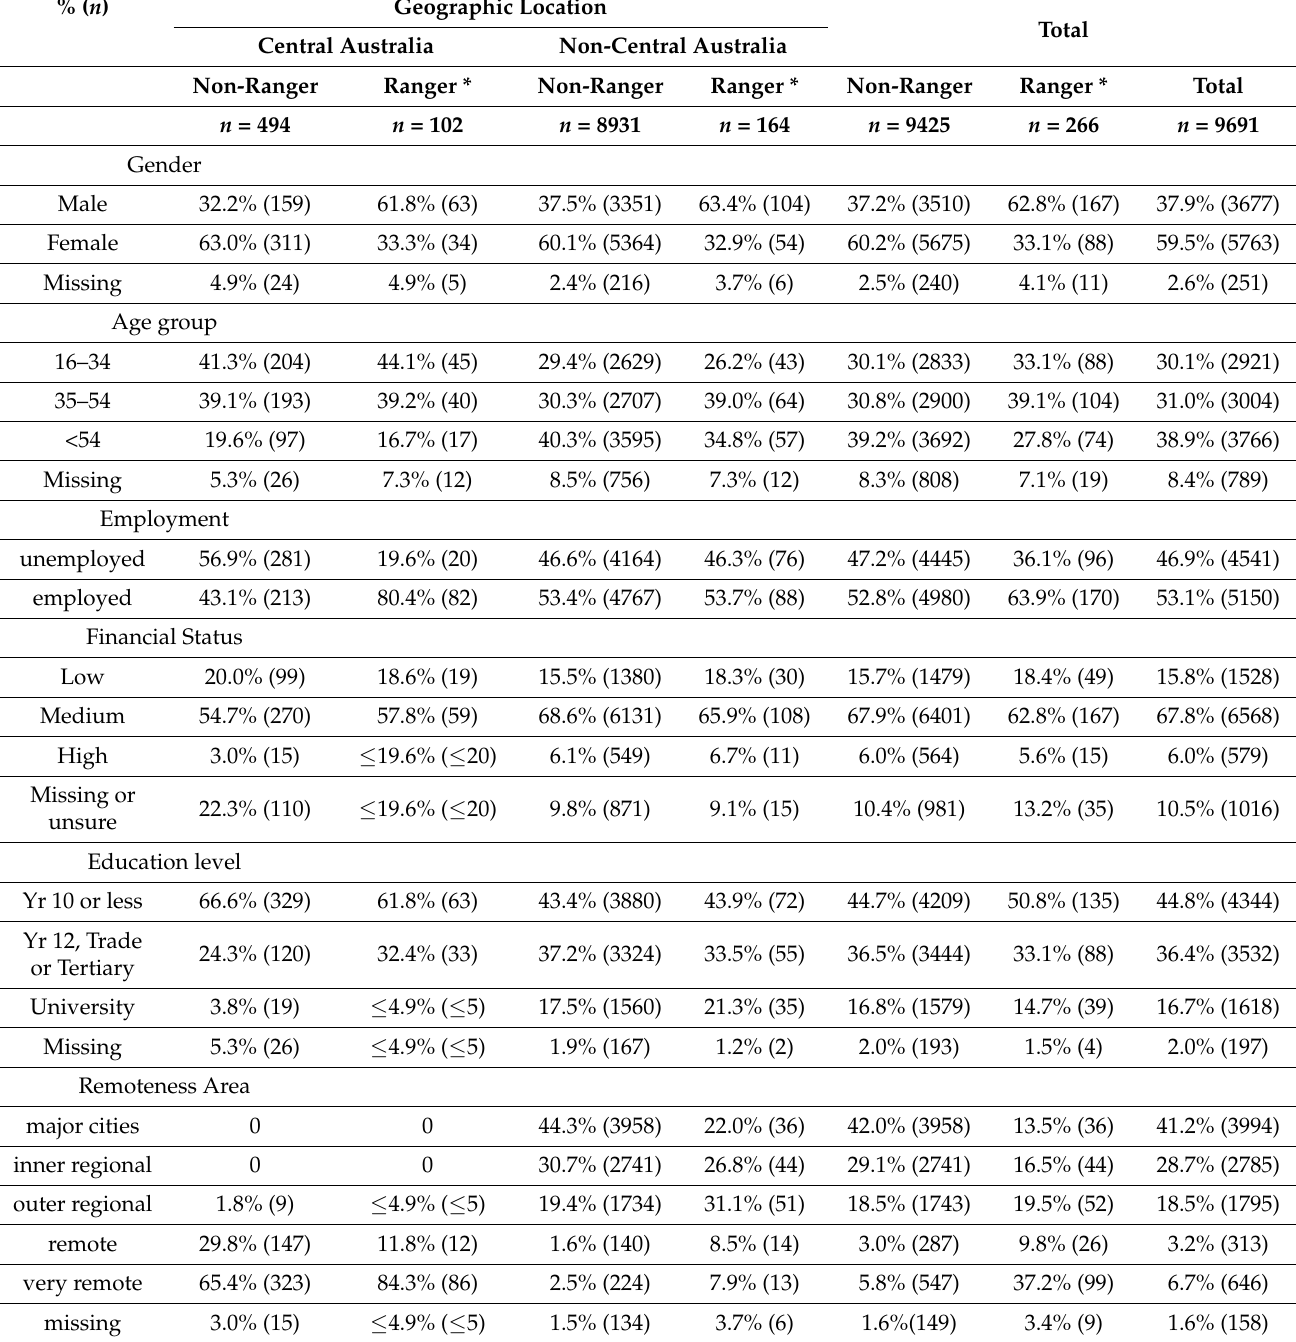
Table 2. Socioeconomic and demographic characteristics of Mayi Kuwayu participants by Ranger status and geographic location. % ( n